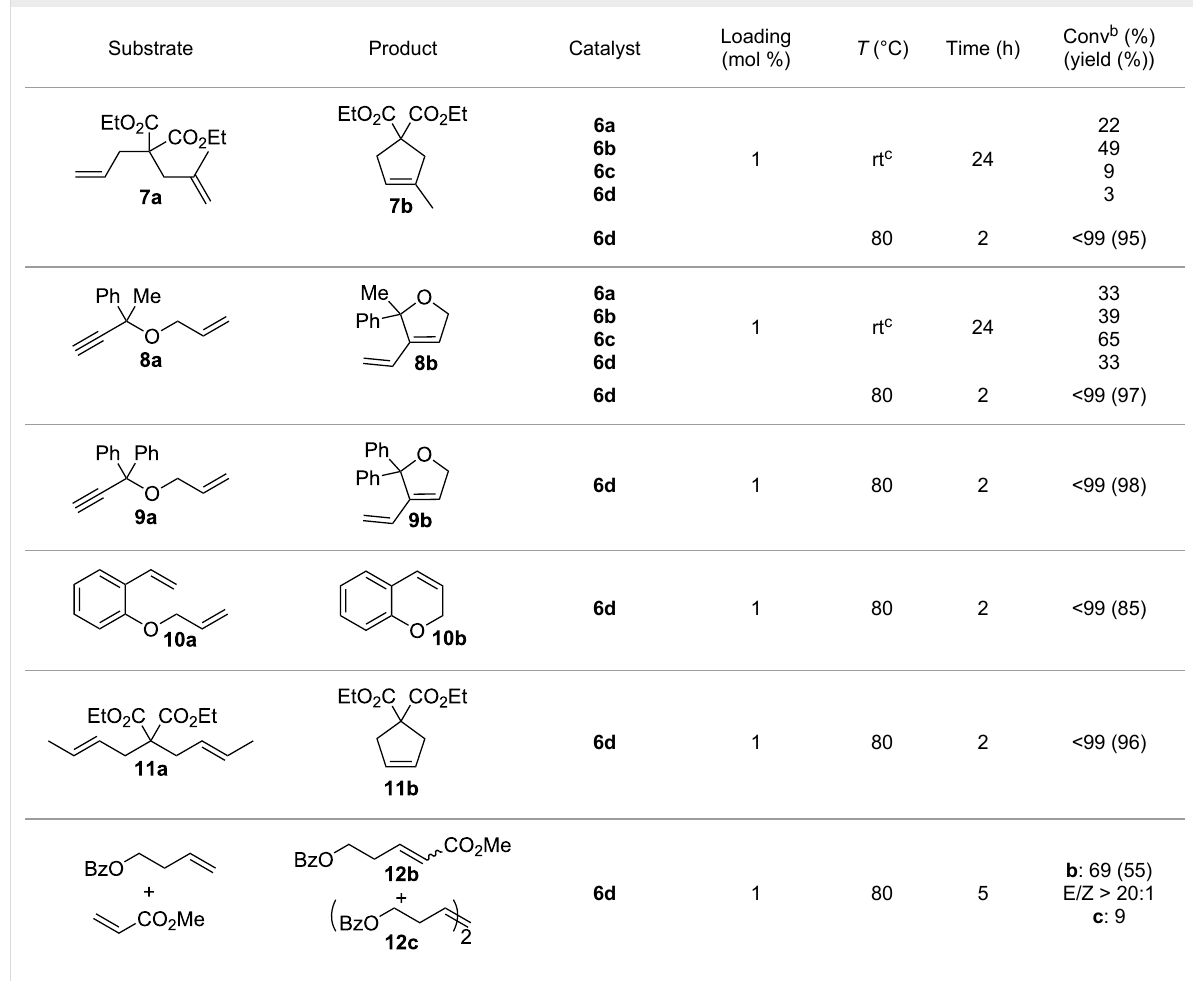
Table 2: Catalytic evaluation of 6a–d in benchmark metathesis transformations. a